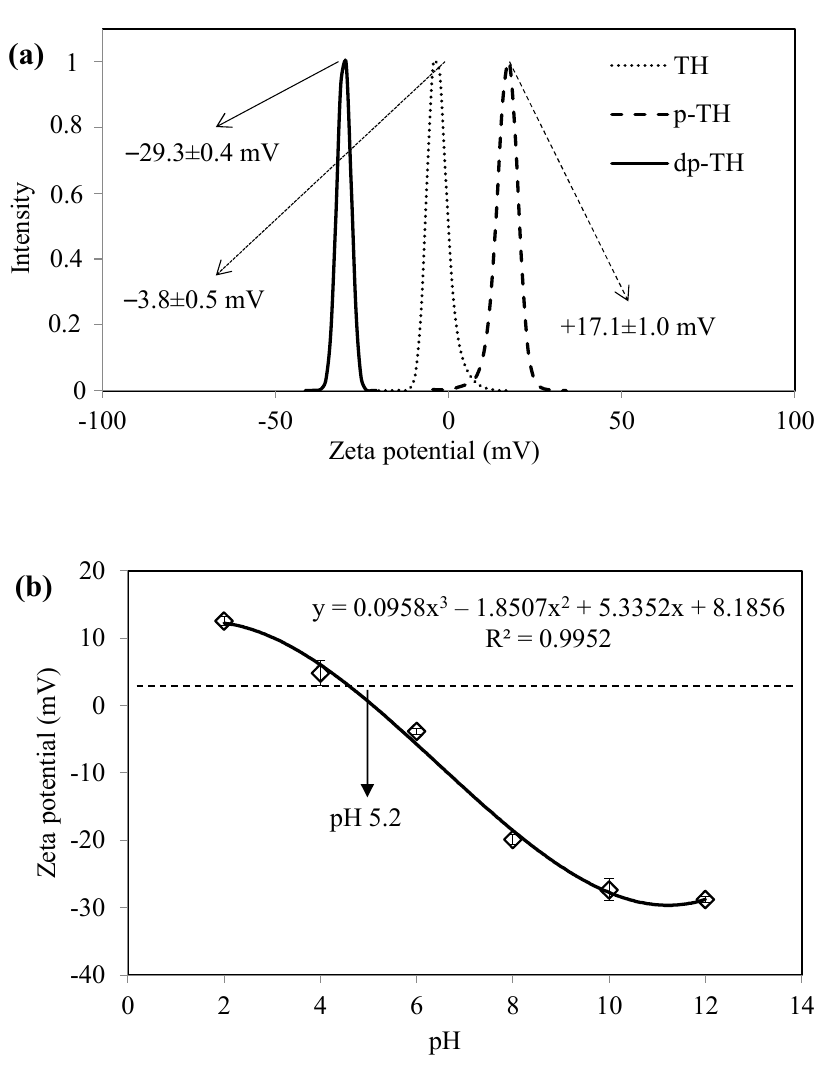
Figure 2. ( a ) Comparison of zeta potential of TH, dp-Th, and p-TH COFs, and ( b ) pH vs. zeta potential plots of TH COFs.